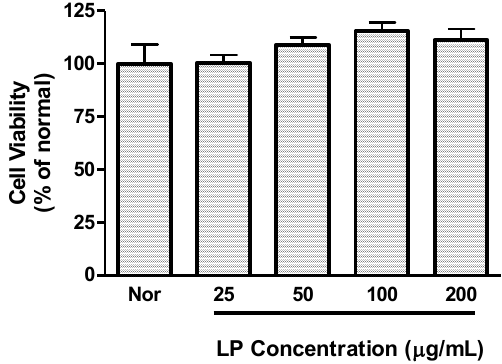
Figure 1. Effects of LP on cell viability. Cell viability was evaluated by a MTT assay 24 h after LP treatment in RAW 264.7 macrophages. Values are the mean ± SEM of three independent experiments.